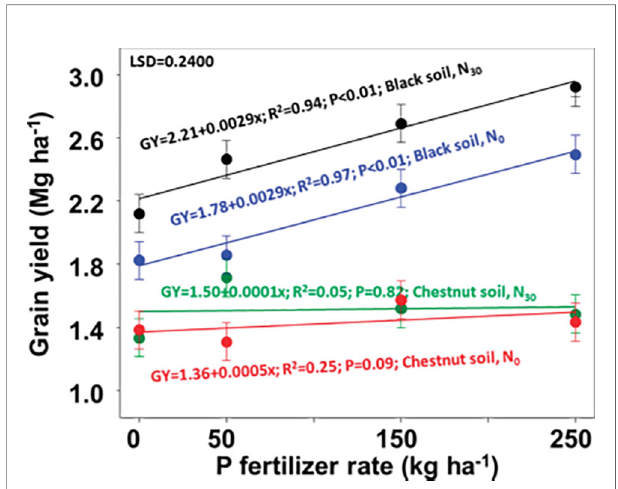
FIGURE 4 | Linear responses of grain yield (GY) to P fertilizer for soil 'N'P intereactions with two soil types; black soil and chestnuts soil (Adopted from: Vargas et al., 2015).